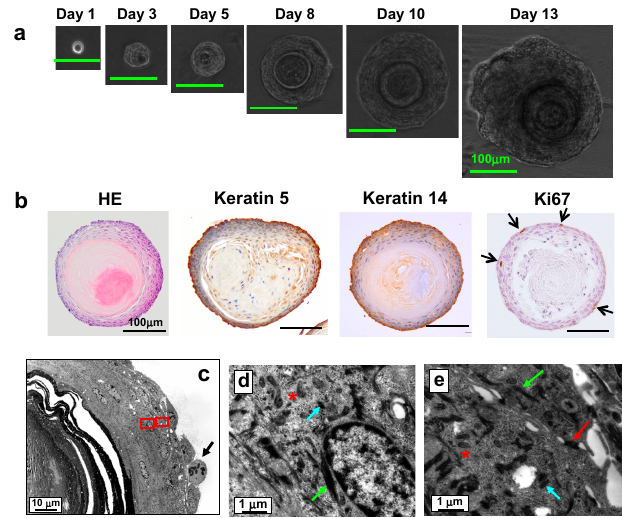
Figure 2. ( a ) Time course of lingual organoid growth. LECs were cultured in the organoid culture system, generating round-shape organoids with a concentric cell arrangement. Phase-contrast image;